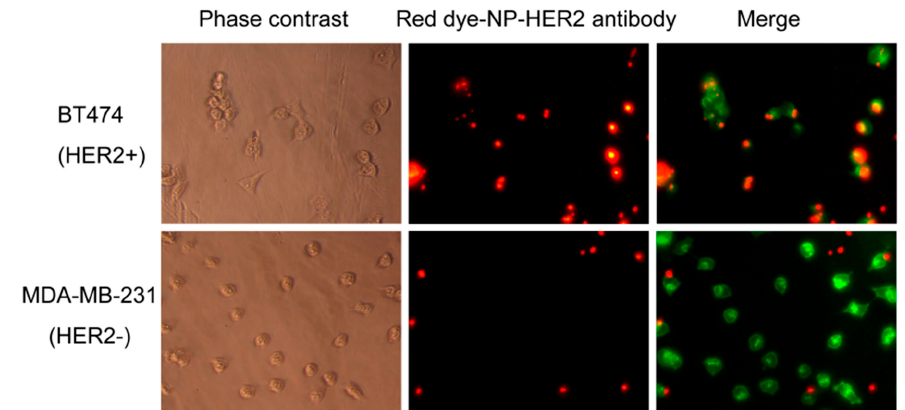
Figure 3. Microscopic images of cell labeling of trastuzumab-conjugated rhodamine-MSNPs (red) for BT474 (HER2+ cells) and MDA-MB-231 (HER2- cells). Cells were counter-stained with phalloidin (green). Left column: Phase contrast images; Middle and Right columns: Fluorescence images (20× magnification).